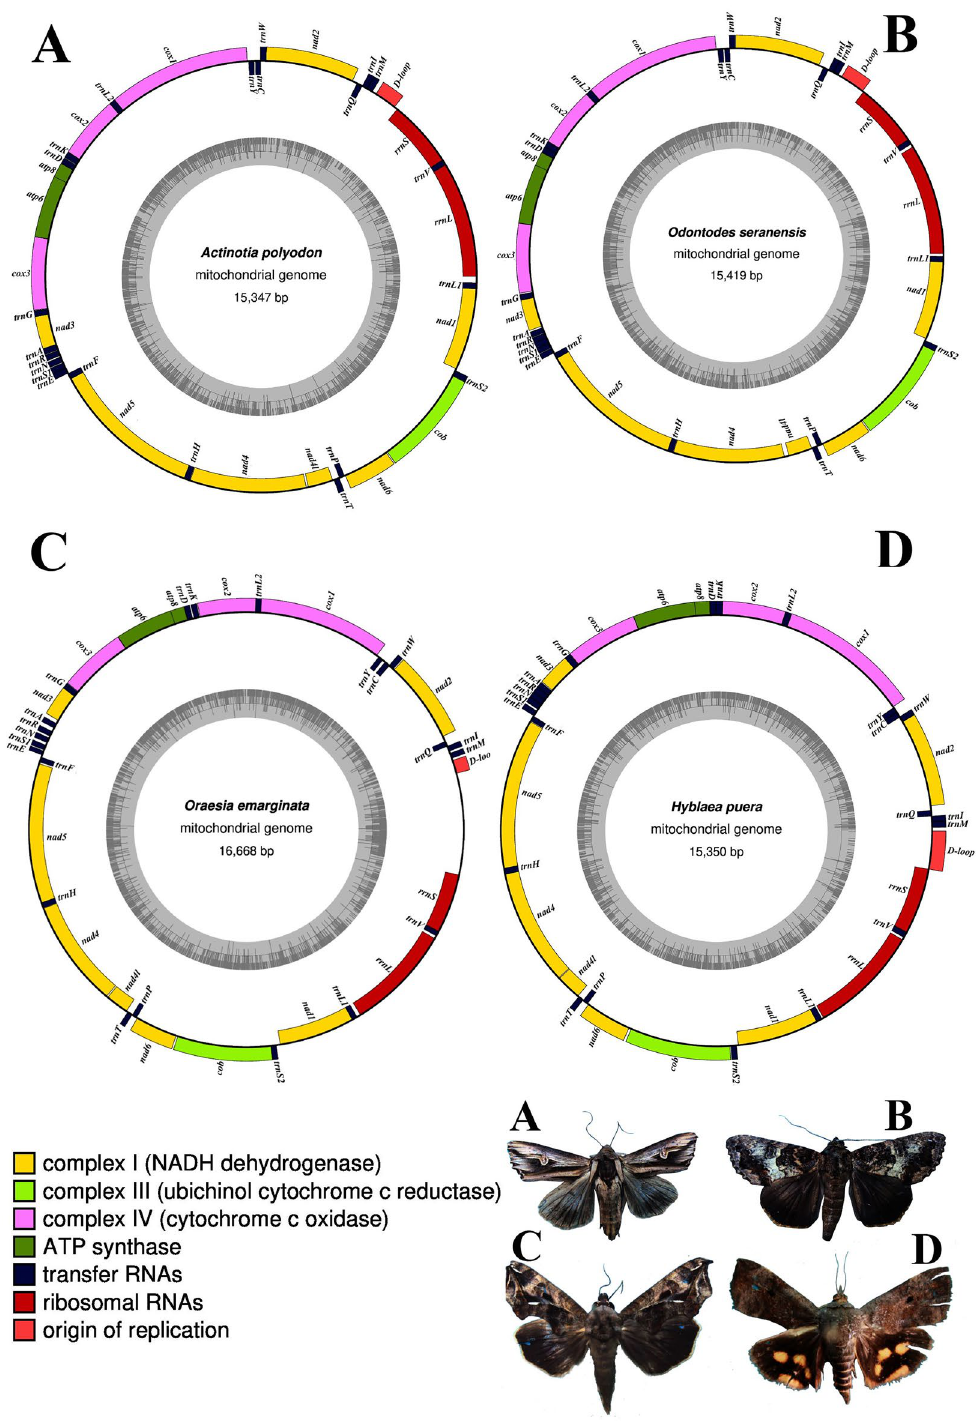
Figure 1. Circular maps of the newly sequenced complete mitochondrial genomes of ( A ) Actinotia polyodon, ( B ) Odontodes seranensis, ( C ) Oraesia emarginata, ( D ) Hyblaea